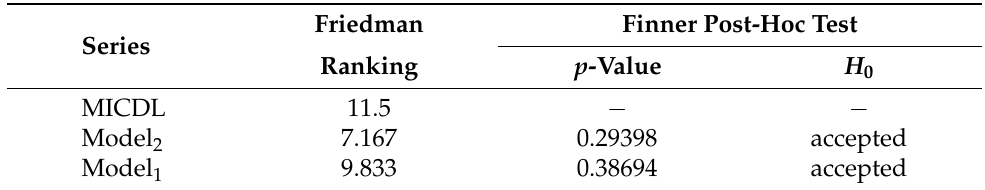
Table 7. Friedman aligned ranking (FAR) test and Finner post hoc test based on the mean absolute error (MAE) metric.